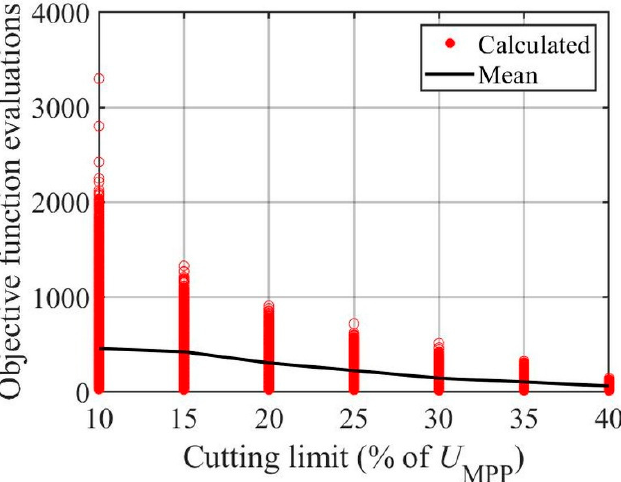
Figure 16. Number of objective function evaluations needed for fitting during the 40 min measure- ment period as a function of the cutting limit based on MPP voltage.